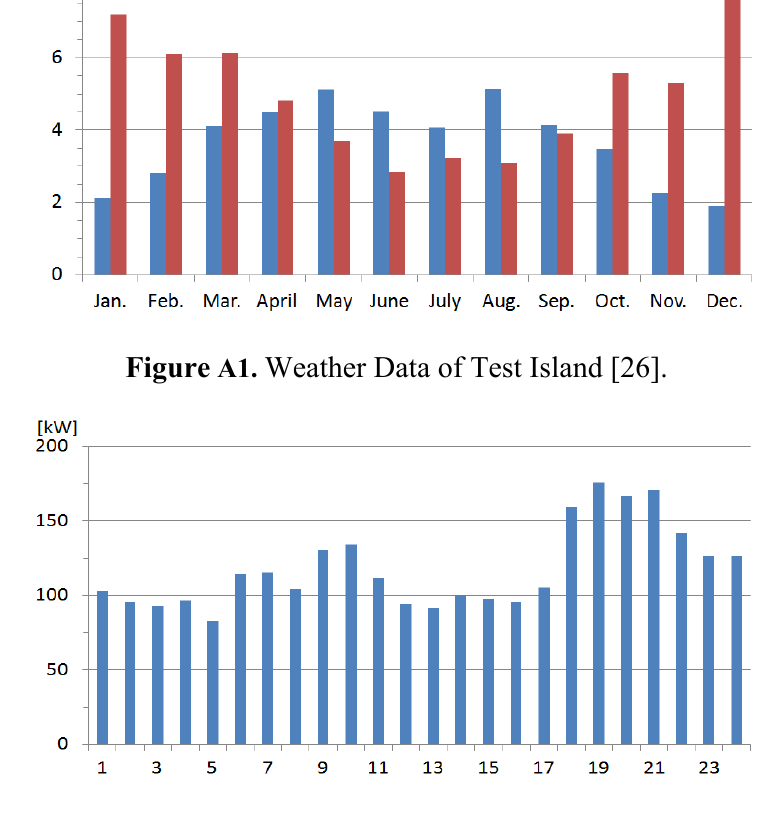
Figure A2. Daily Load Profile of Test Island (January)